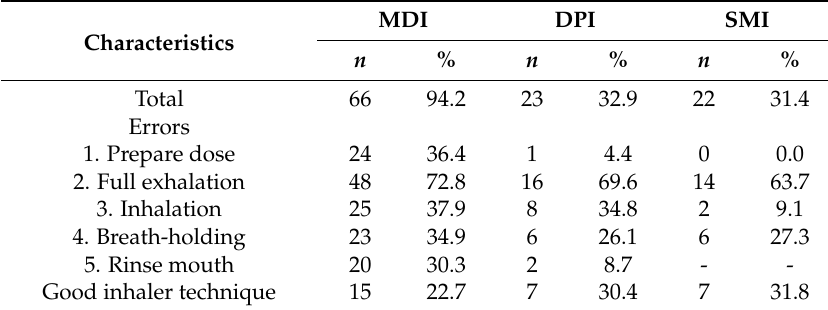
Table 2. Frequency of critical errors according to type of inhaler.